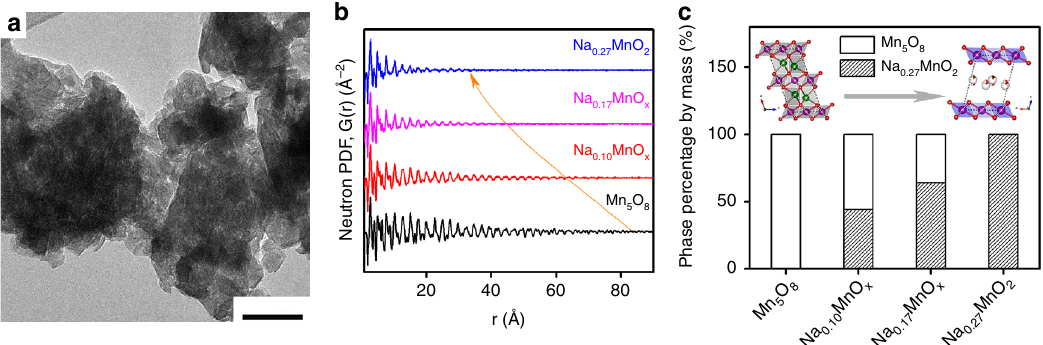
Fig. 1 TEM and neutron PDF analysis of sodium-manganese oxides. a TEM image of of Na 0.27 MnO 2 materials; scale bar, 50 nm; b Experimental neutron PDFs of Na δ MnO x materials, where coherent lengths, de fi ned as the longest interatomic distance of the material, decreased as the Na concentration increased; c Phase percentage of Na 0.27 MnO 2 in Na δ MnO x materials obtained from neutron PDF